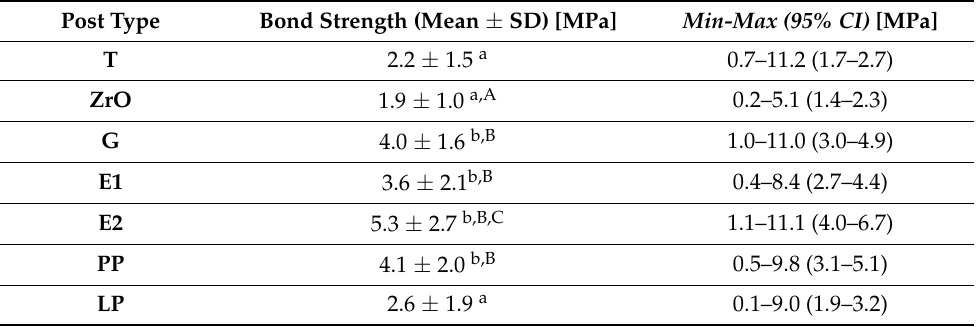
Table 2. The mean bond strength values (mean ± standard deviation (SD)) (in MPa) of T, ZrO, G, E1, E2, PP and LP. Minimum, Maximum and 95%-Confidence Interval of mean bond strength values of T, ZrO, G, E1, E2, PP and LP. Bond strength values with different superscripts a, b, A, B, C are significantly different from each other.